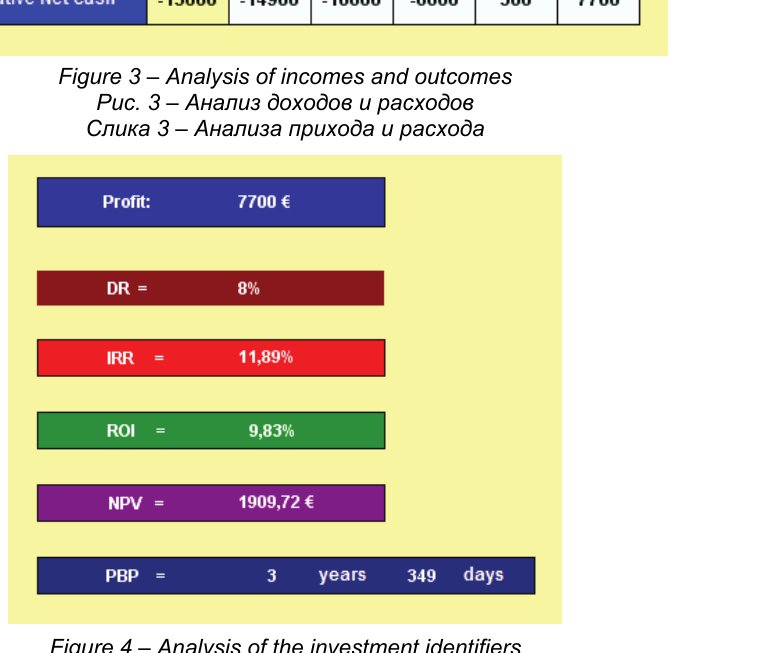
Figure 4 – Analysis of the investment identifiers Рис . 4 – Анализ инвестиционных показателей Слика 4 – Анализа инвестиционих